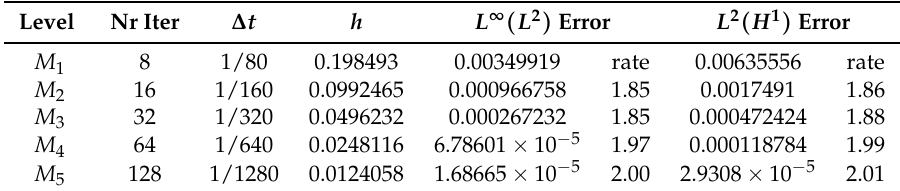
Table 1. L ∞ ( L 2 ) and L 2 ( H 1 ) errors and rates for the the Leray- α model. The final time is T = 0.1. The predicted rate order is 2.